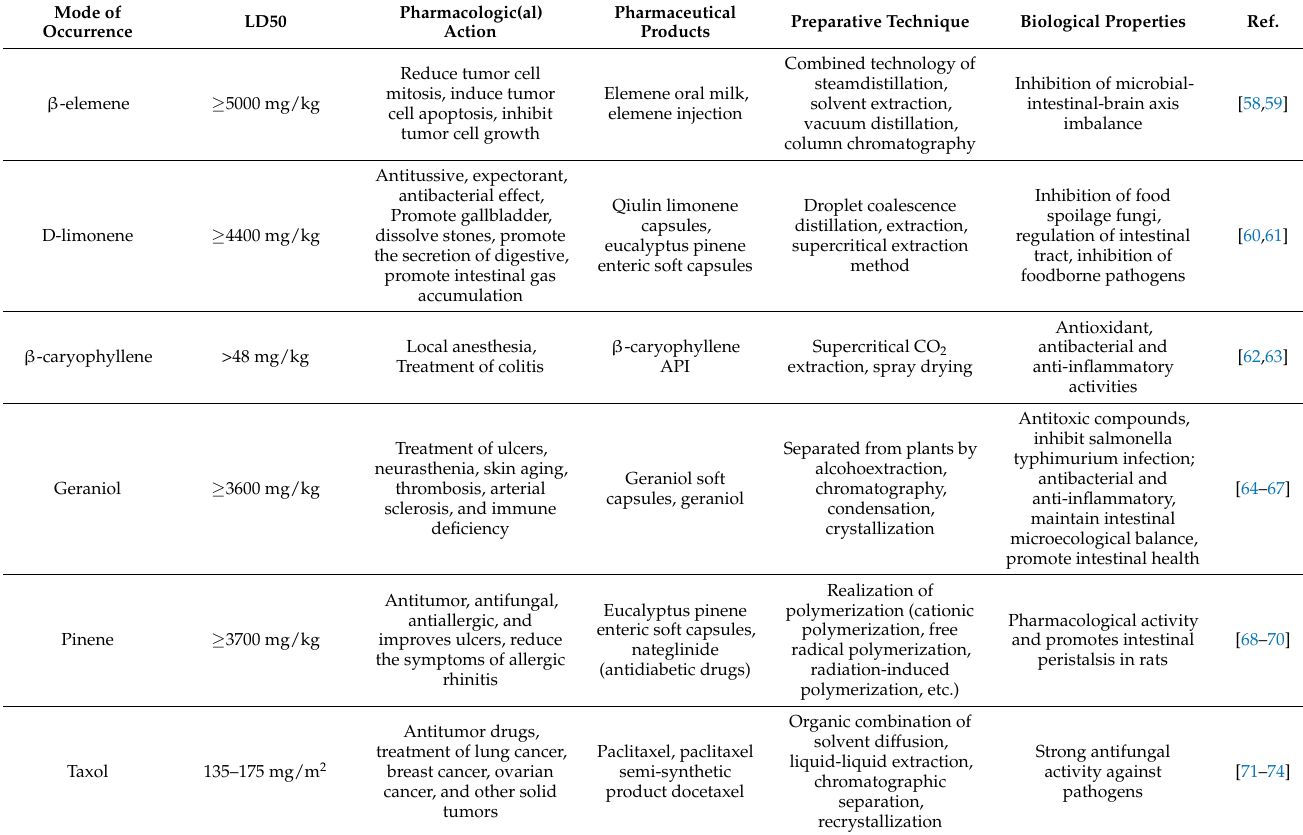
Table 2. Common terpenes in medicine and their medicinal